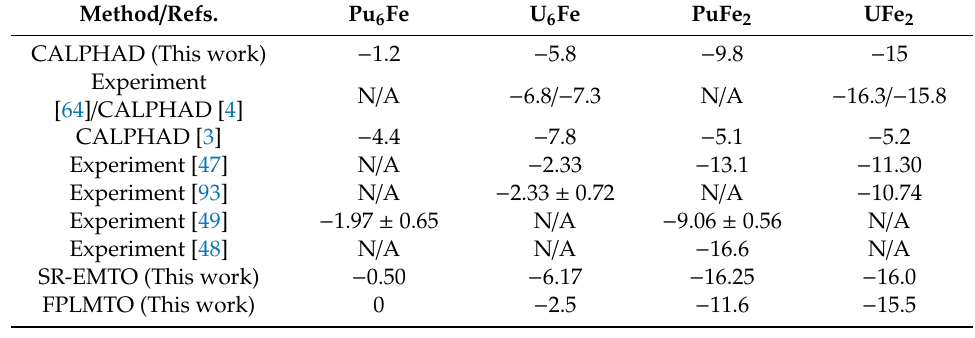
Figure 1. Calculated Pu-Fe phase diagram based on the present CALPHAD assessment and compared with experimental data [45,46].